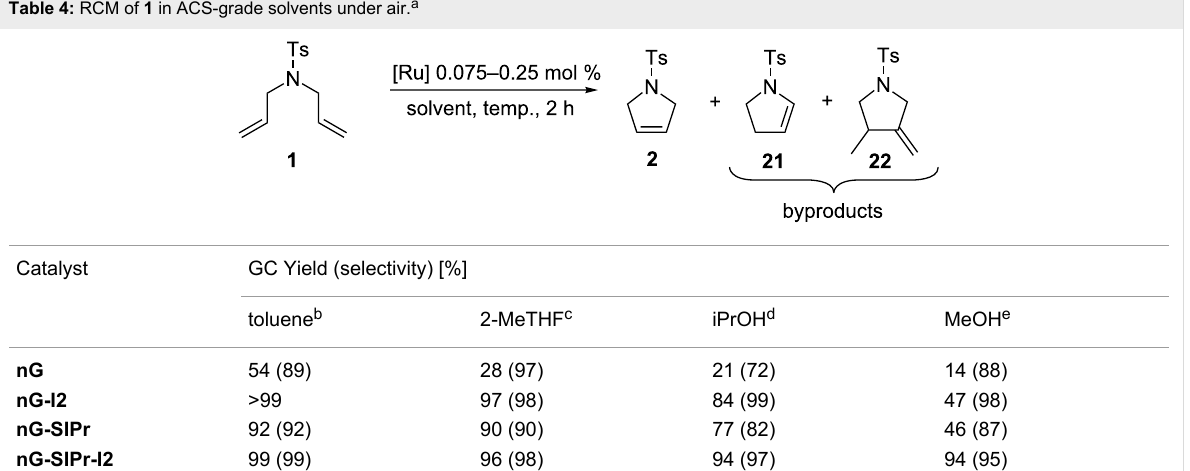
Table 4: RCM of 1 in ACS-grade solvents under air.